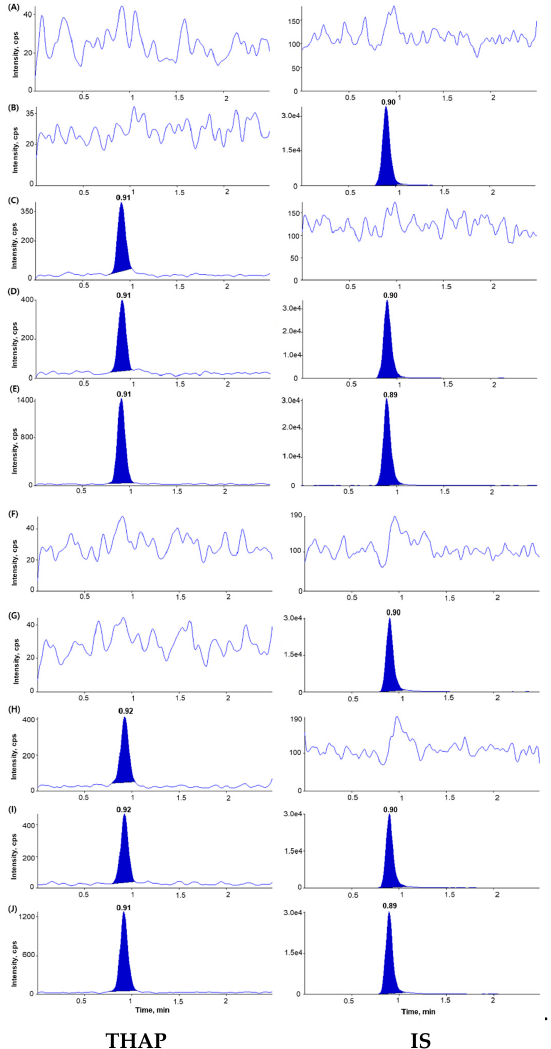
Figure 2. Representative chromatograms of: ( A ) blank rat plasma; ( B ) blank rat plasma spiked with IS (2 µ g / mL); ( C ) blank rat plasma spiked with THAP (0.1 µ g / mL, lower limit of quantitation (LLOQ)); ( D ) blank rat plasma spiked with THAP (0.1 µ g / mL, LLOQ) and IS (2 µ g / mL); ( E ) rat plasma sample of R06 12 h after oral administration of THAP 500 mg / kg (measured concentration 0.374 µ g / mL); ( F ) blank dog plasma; ( G ) IS-spiked (2 µ g / mL) dog plasma; ( H ) THAP-spiked (0.1 µ g / mL, LLOQ) blank dog plasma; ( I ) blank dog plasma spiked with both THAP (0.1 µ g / mL) and IS (2 µ g / mL); and ( J ) dog plasma sample of R05 24 h after oral administration of THAP 500 mg immediate-release tablet (measured concentration 0.302 µ g / mL). Panels on the left side were chromatograms for THAP while those on the right side were for